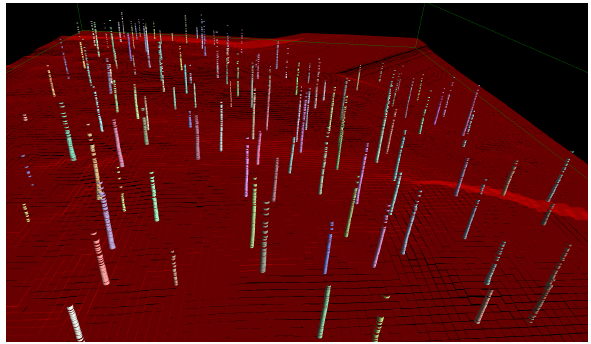
Figure 3. Stem diameter cylinders and